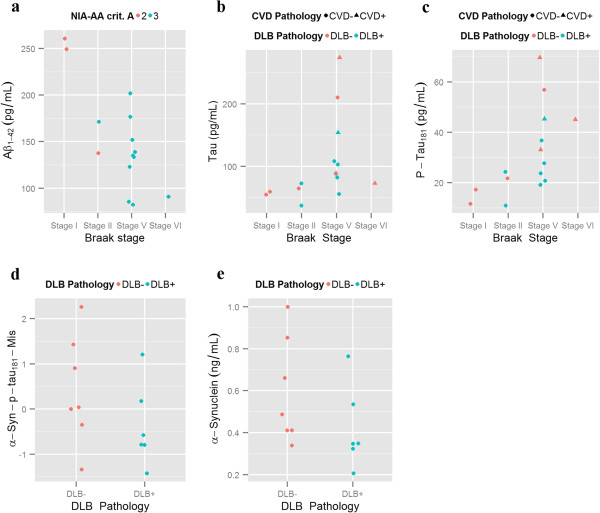
CSF biomarker correlates. a) Aβ1-42 levels based on a) NIA-AA criteria A score and Braak score. b)T-tau and c) P-tau181 levels based on Braak stage. d) α-Synuclein-p-tau181 mismatch and e) α-Synuclein based on presence or absence of coincident DLB and SVD-I.